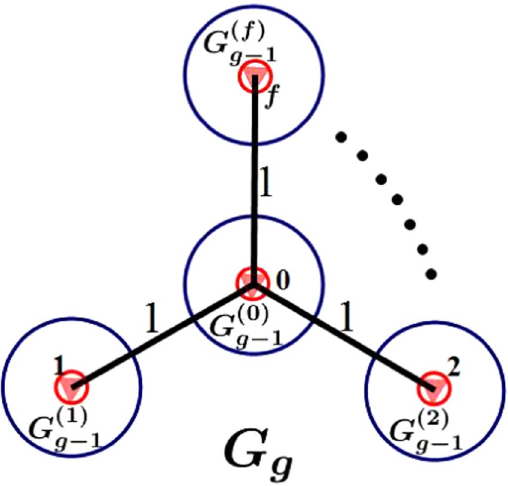
Figure 2. Construction method of weighted polymer networks. The open circles and triangles represent Node i ( ) and i of =  G i f ( 0, 1, 2, , ) i ′ of − G , 1 g 1